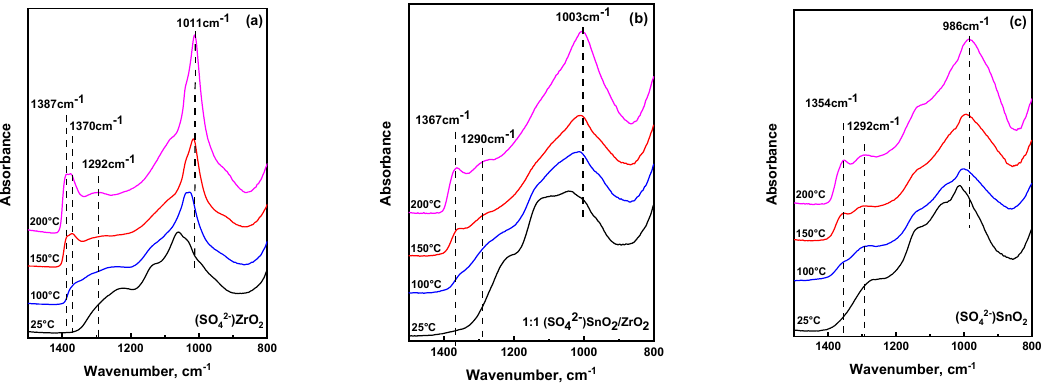
Figure 4. Temperature dependent ATR-IR spectra of the ( a ) (SO 42 − ) ZrO 2 , ( b ) 1:1 (SO 42 − )SnO 2 / ZrO 2 , and ( c ) (SO 42 − )SnO 2 up to 200 ◦ C. Spectral resolution was set to 4 cm − 1 , while 32 accumulations have been used to increase signal / noise ratio.